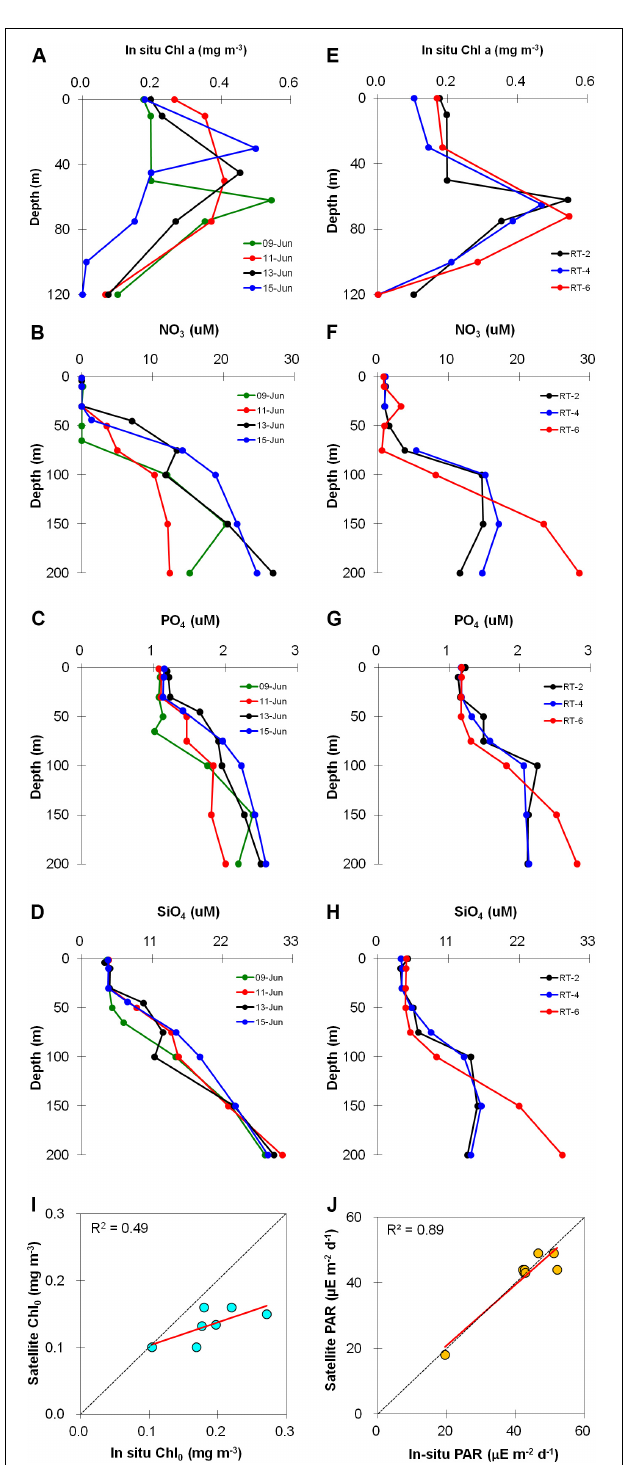
FIGURE 3 | Depth profiles of phytoplankton biomass (only for the locations where primary productivity was measured), and nutrients for TS (A–D) and RT (E–H) stations. Scatter plots of (I) chlorophyll a and (J) photosynthetically active radiation measured by in situ and satellite remote sensing methods. Legends for TS and RT stations are given in respective figures. The dotted diagonal line indicates 1:1